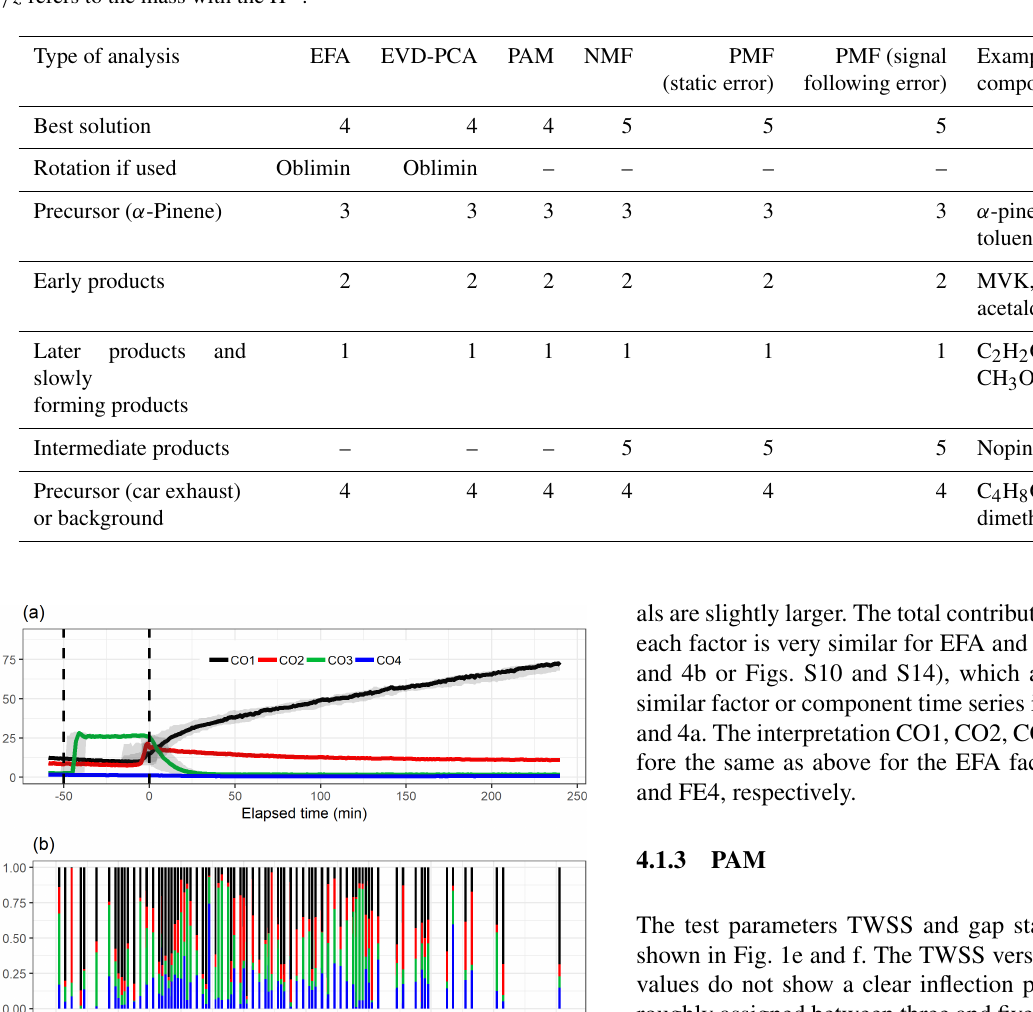
Table 1. Summary of the results for gas-phase composition data. Best solution refers to the number of factors, clusters or components. The m/z refers to the mass with the H + .